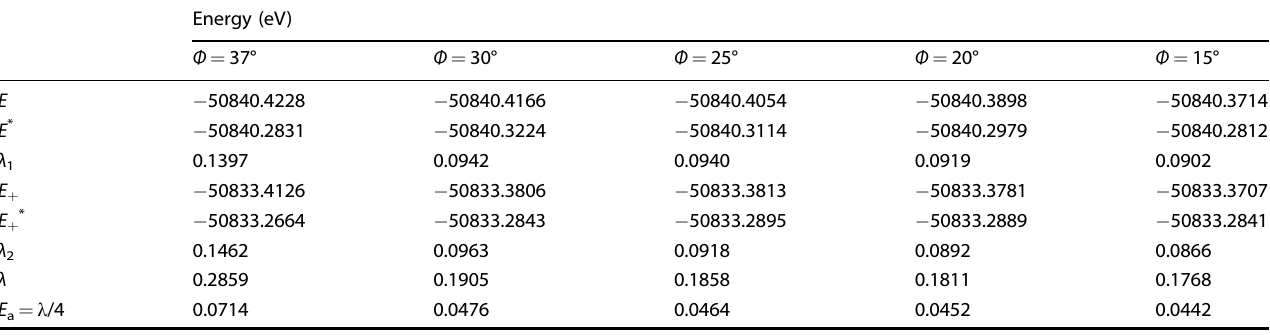
Table 2. Variation in the reorganization energy ( λ ) and activation energy ( E a ) with respect to the dihedral angle ( Φ ) between the donor and the acceptor moieties of